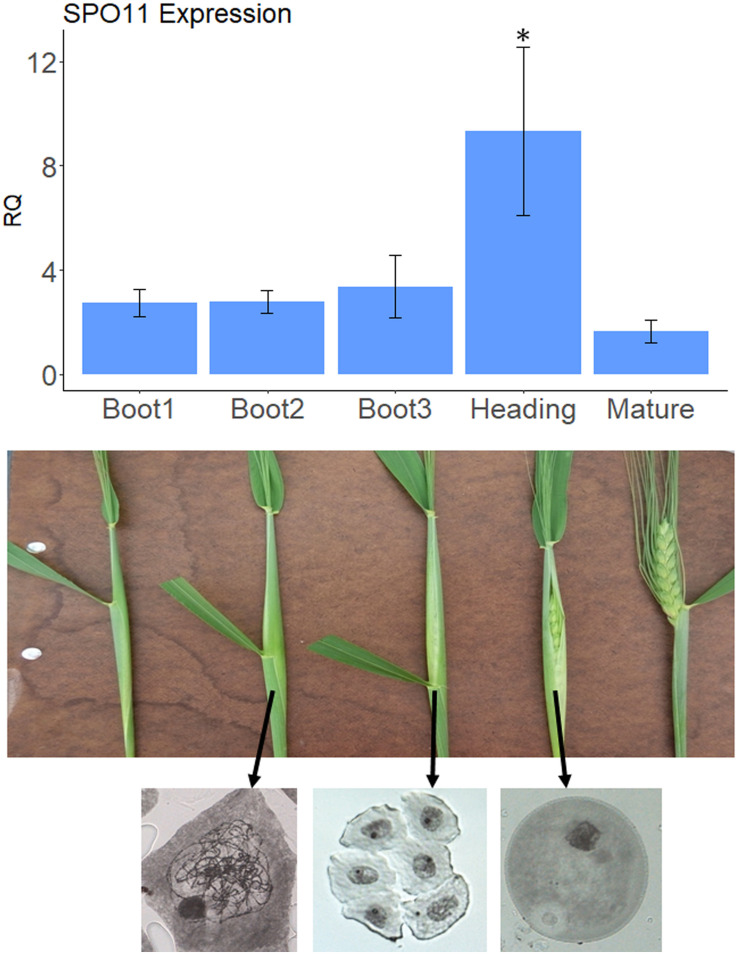
SPO11 expression at different developmental stages. The upper panel shows relative expression levels of SPO11 as determined by qPCR, during five developmental stages of the spike, shown in the bottom panel for cv. Svevo. The reference gene was Actin. Bars represent SE, the number of replica, N = 3, Asterisk designate significant differences from the Mature stage (p < 0.05). The bottom panel shows meiotic stage analysis by Acetocarmine staining of male meiocytes taken from the middle spikeletes at different physiological stages. Arrows show origin of stained meiocyes. Left, zygotene; Middle, tetrad; Right, young pollen.